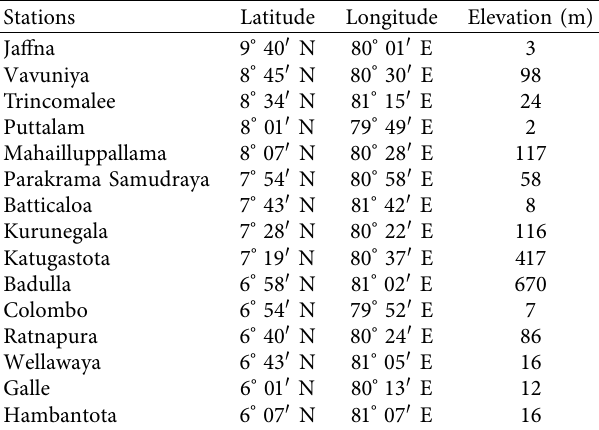
Figure 1: Locations of the rain gauge stations under review. Table 1: Geographical information of rain gauge stations.